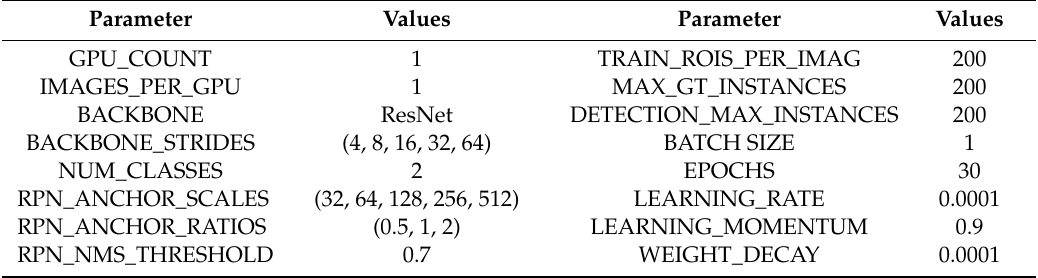
Table 6. Main parameter information of the